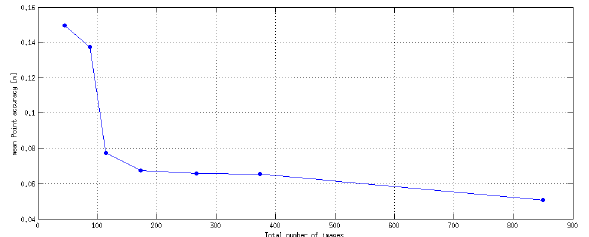
Figure 10: Error curve for different image subsets before GCP constrained bundle adjustment. With increasing total number of images per subset, the mean reconstruction accuracy increases.